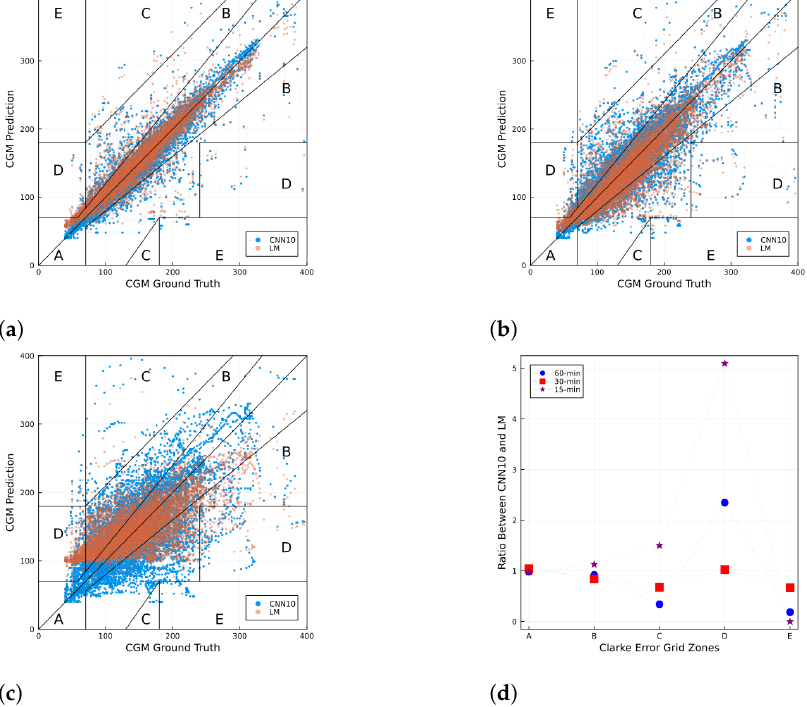
Figure 6. Clarke error grid for CGM prediction using the CNN10 and a sample in the test set for ( a ) 15, ( b ) 30, and ( c ) 60 min horizons. Panel ( d ) shows the ratio of the number of points between CNN10 and LM that fall in each zone in the Clarke error grid for the three different prediction horizons. For each zone in the x -axis, values above (below) 1 imply a larger (smaller) number of points from the CNN10 than the LM. In the case of the CNN10, the fraction of points in each zone are: ( a ) ρ